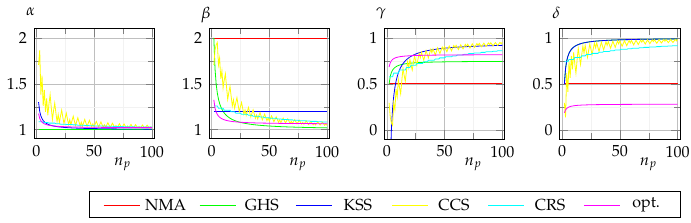
Figure 2. Comparison of NMA adaptive schema parameters.